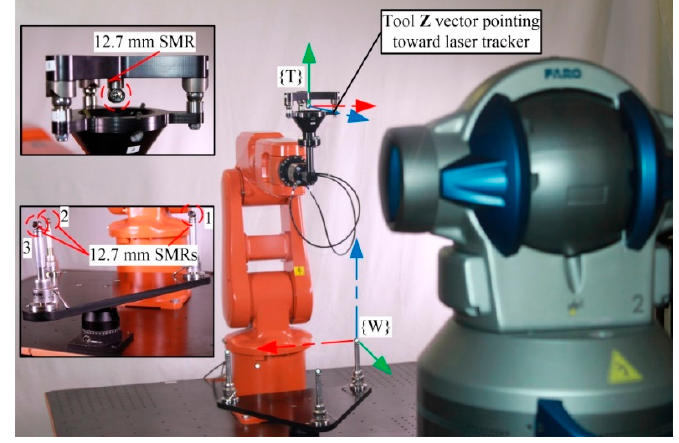
Figure 6. Experimental setup 2.